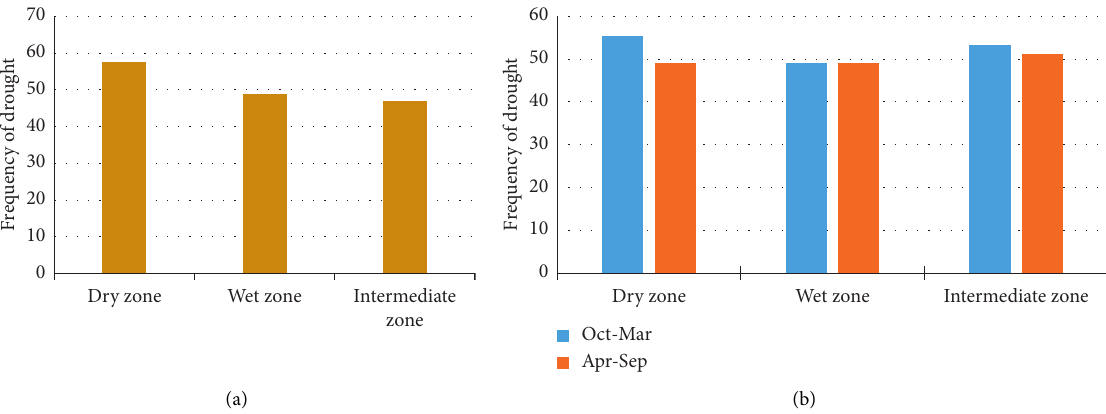
Figure 5: Frequency of drought in climatological zones at the (a) annual time scale and (b) 6-month time scale based on Thiessen polygon average rainfall for wet, dry, and intermediate